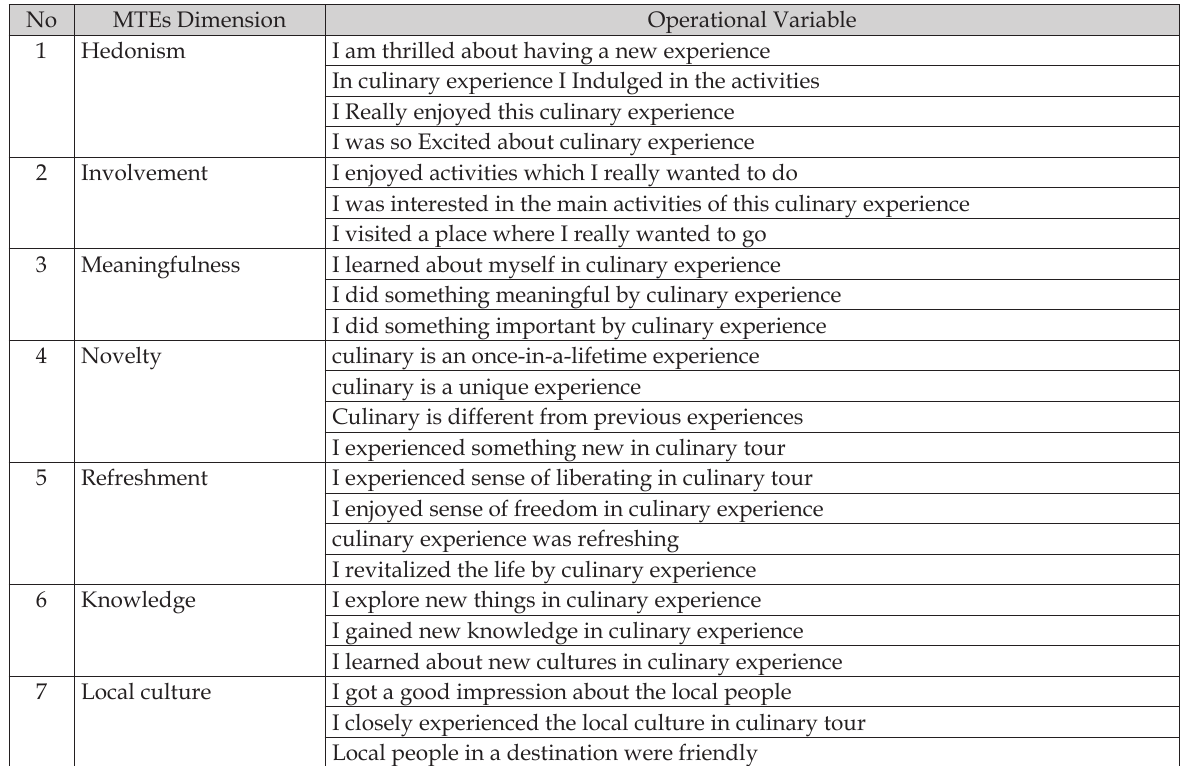
Table 1. The research variables.